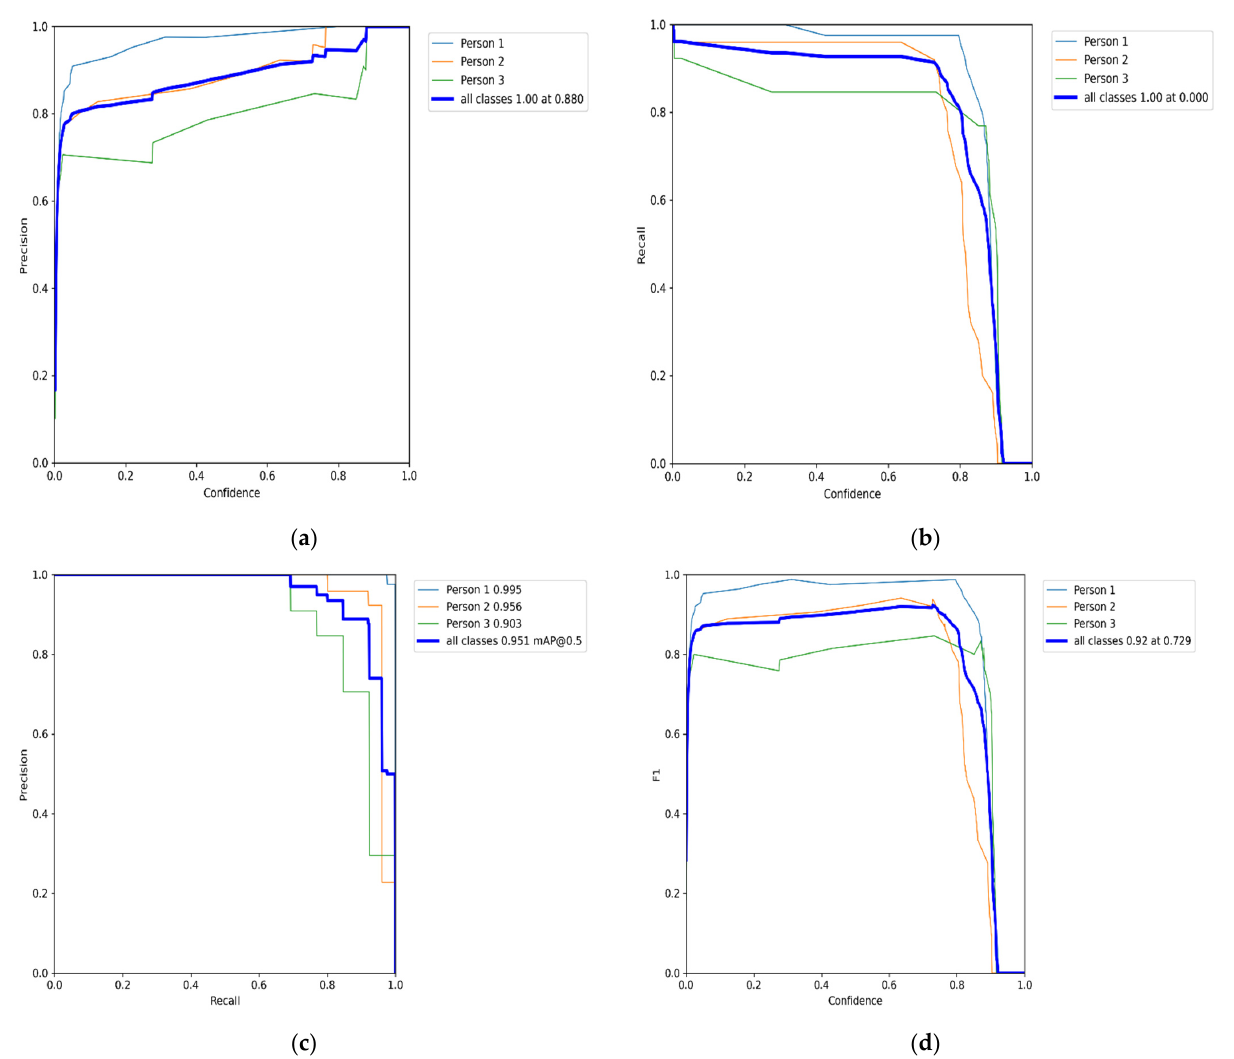
Figure 5. The label ( a ) shows the precision (P) versus confidence (C) graph, ( b ) the recall (R) versus confidence (C), ( c ) is the mean average precision based on comparing the truth bounding box and detection box, and ( d ) the IDF1 score at 92% with confidence of 0.729, advocates the balancing between the P and R based on Campus scenes images dataset. The mAP for all classes is high and accurately modeling detections at 95.1% with a threshold of 0.5. The P and R are high at 88.0%, and 87.5%, respectively, and more confidence at 0.8 and 0.78, respectively, for all classes. The algorithm has proven to be effective with high performance in precision and re- call, accompanied by the high confidence values on the campus scene dataset. It achieved Table 4. Performance evaluation analysis of fine-tuned Yolo5Deep on EPFL dataset (campus and a greater balance between precision and recall, with a mean average precision of 95.1% at